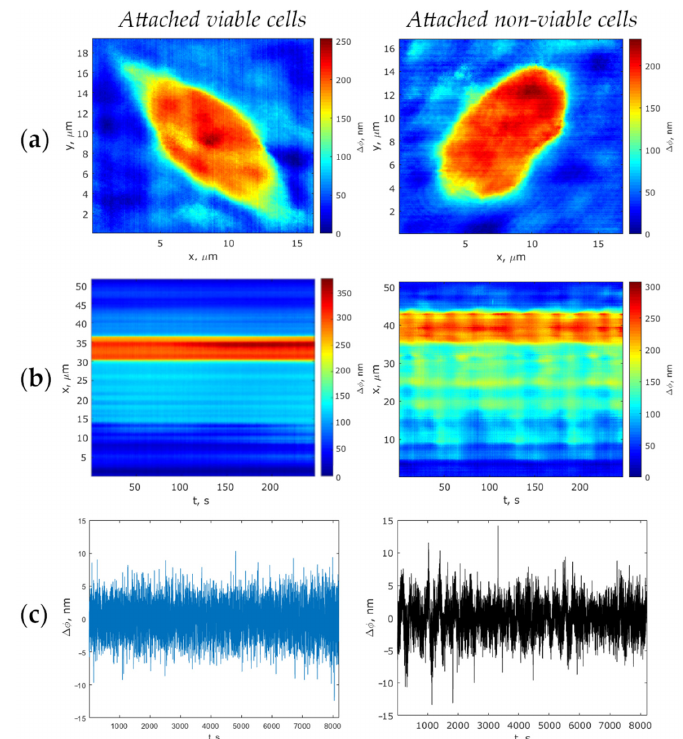
Figure 3. Comparison of viable and non-viable cells attached to the substrate: ( a ) Phase images; ( b ) Track diagrams; ( c ) Phase thickness fluctuations of the cells. In the x-direction, spatial coordinates ( a ), and time ( b , c ) are positioned; in the y-direction, spatial coordinate ( a , b ) and phase thickness ( c ) are positioned.